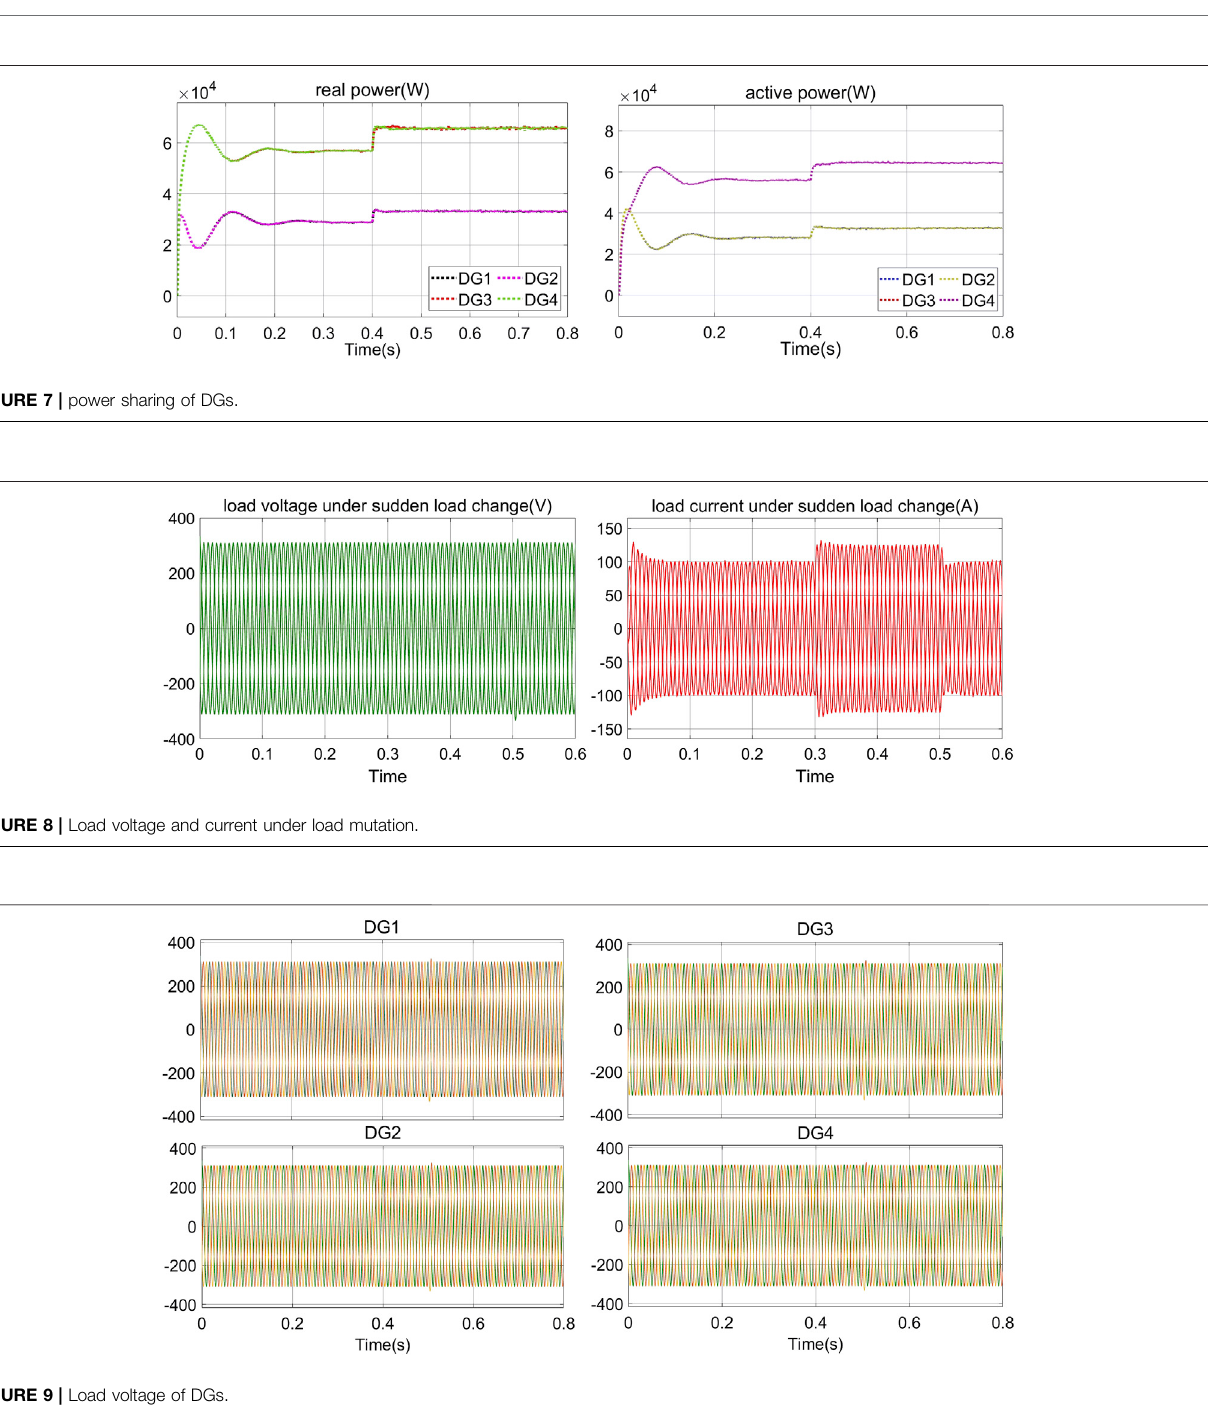
FIGURE 9 | Load voltage of